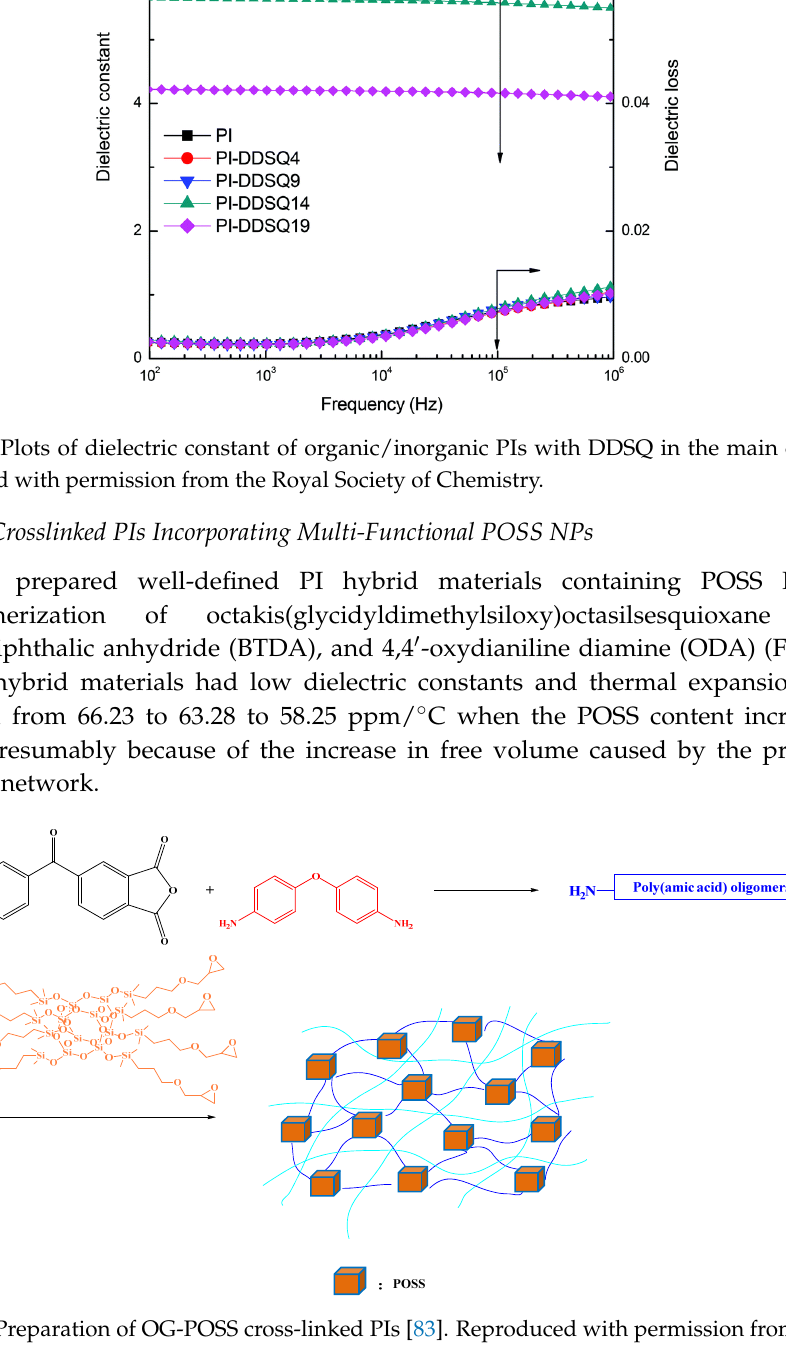
permission from the Royal Society of Chemistry.